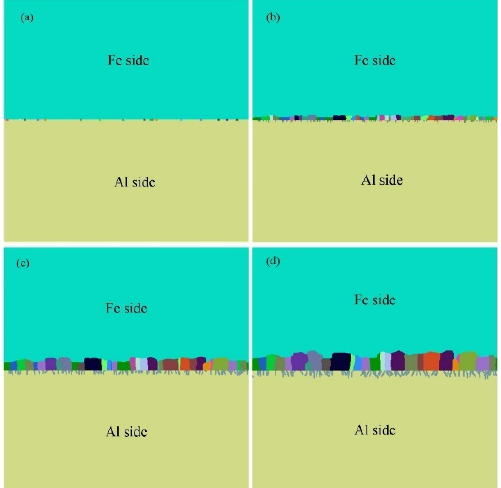
Figure 13. Simulated IMCs microstructure at different Monte Carlo steps: ( a ) 15,000 mcs, ( b ) 20,000 mcs, ( c ) 25,000 mcs, and ( d ) 30,000 mcs.